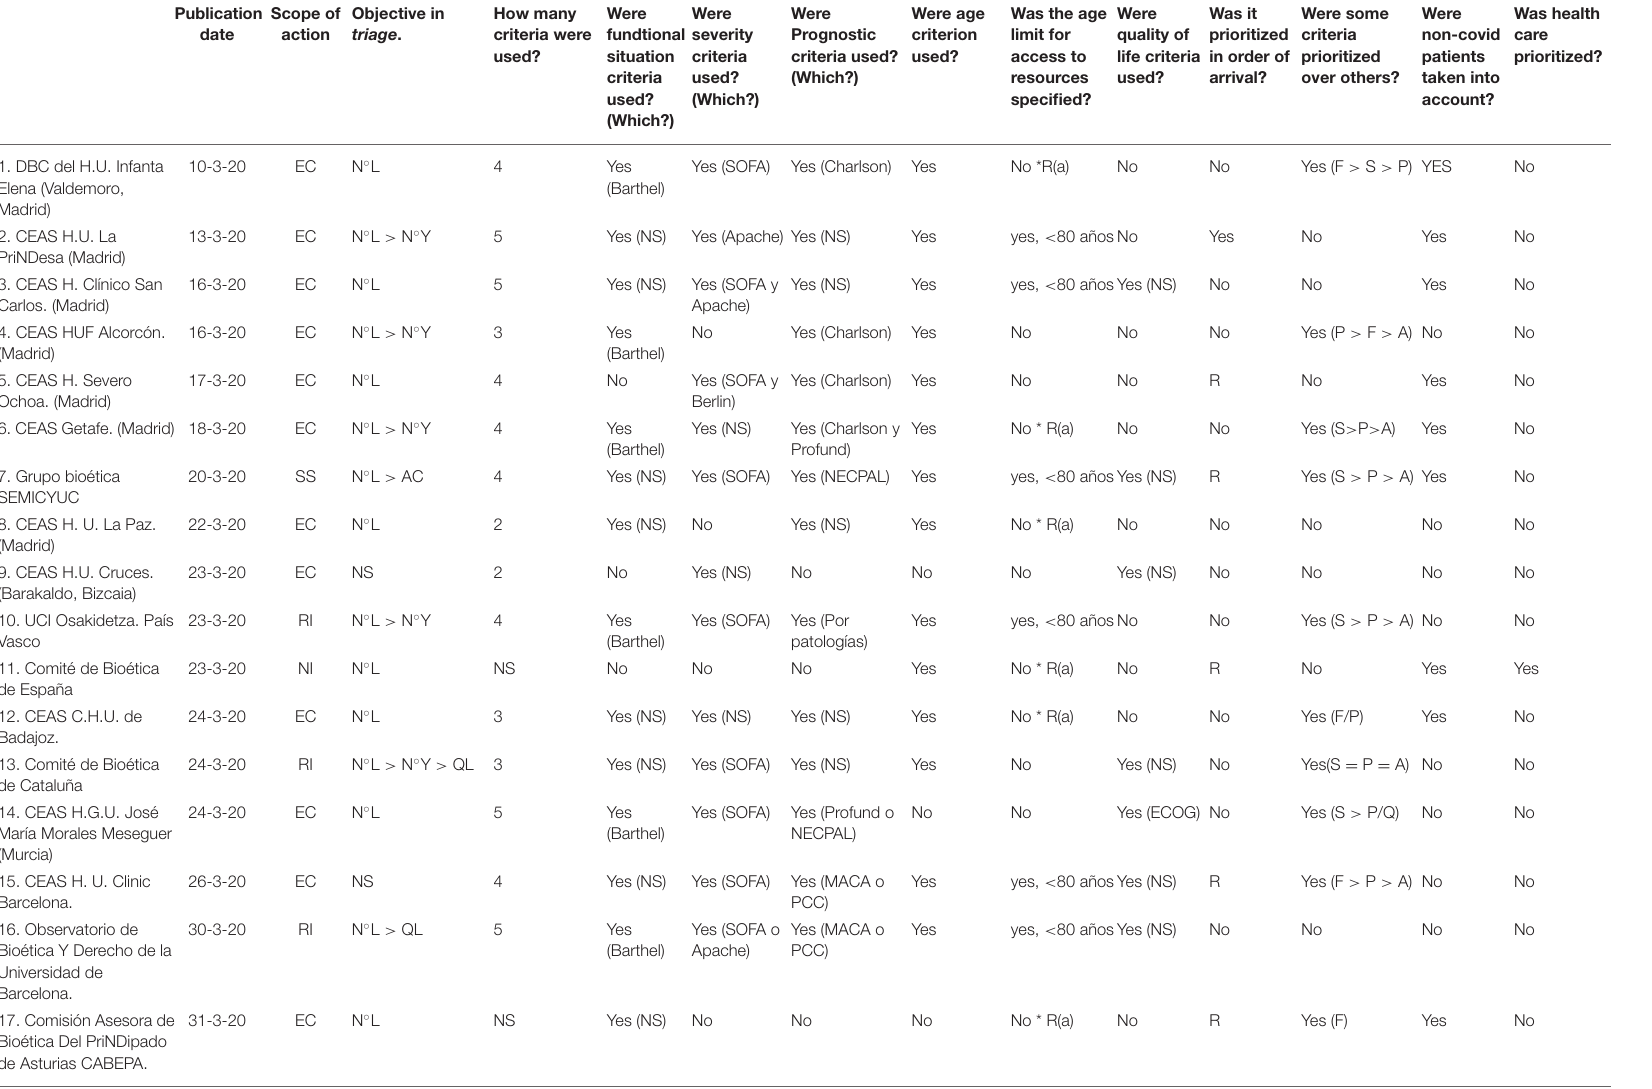
TABLE 1 | Main data of the analyzed